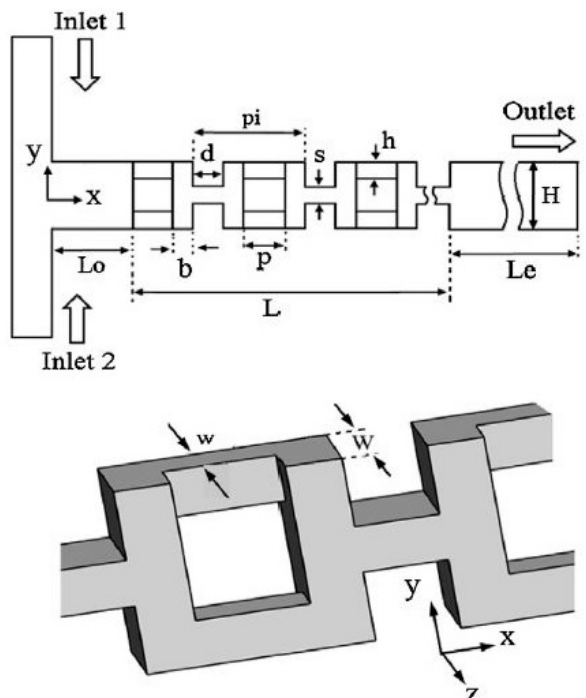
Figure 5. 3D serpentine micromixer: M ‐ 5 (no. of mixing units used: 8). Reproduced with permission from [45].